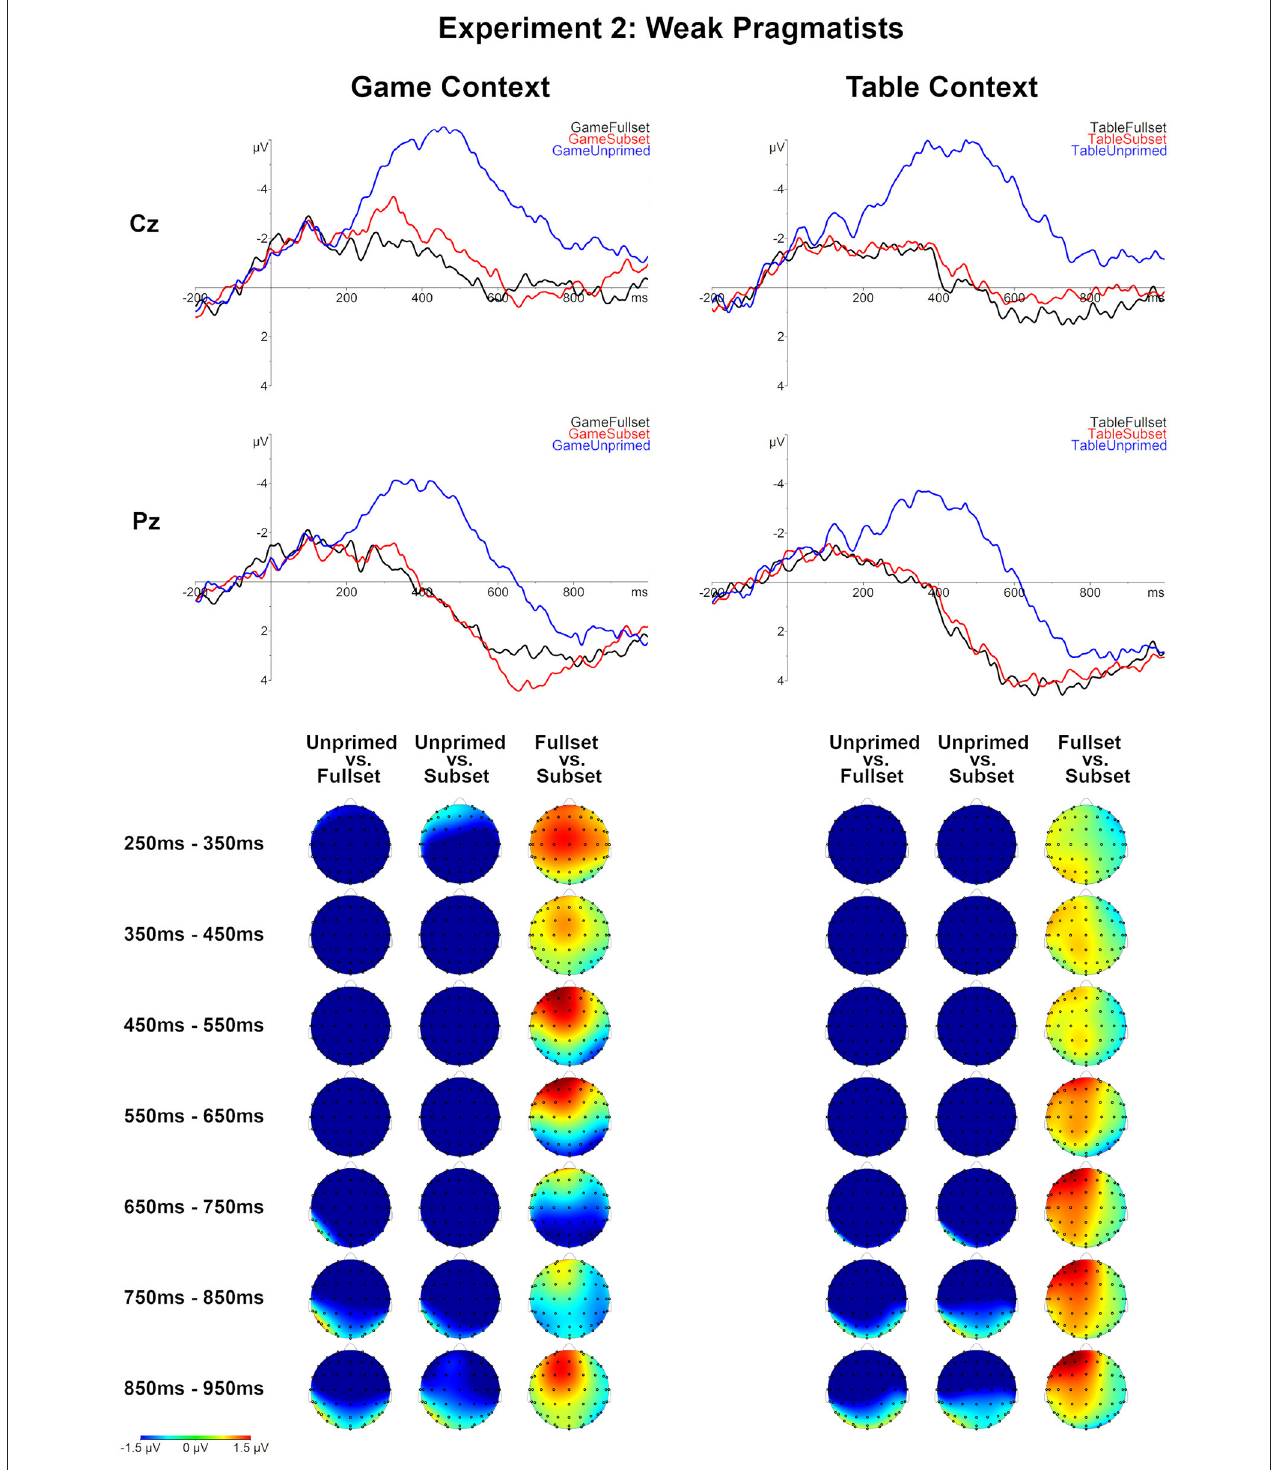
FIGURE 6 | Grand averages for all conditions for weak pragmatists ( N = 15), Experiment 2. Topographical maps of the differences between the compared Set levels separately for the Table and Game context in consecutive 100 ms time-windows, between 250 and 950 ms post-onset.